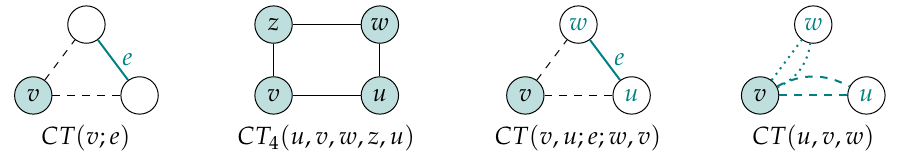
Figure 1. The first closed trail contains the vertex v , the edge e and the other elements of the graph. The second closed trail contains only the vertices u , v , w , z and has a length equal to 4. The third closed trail contains the vertex v , the edge e with the incident vertices u , w , and the other elements of the graph. The fourth closed trail CT ( u , v , w ) contains two closed trails CT ( u , v ) and CT ( v , w ) that have common vertex v